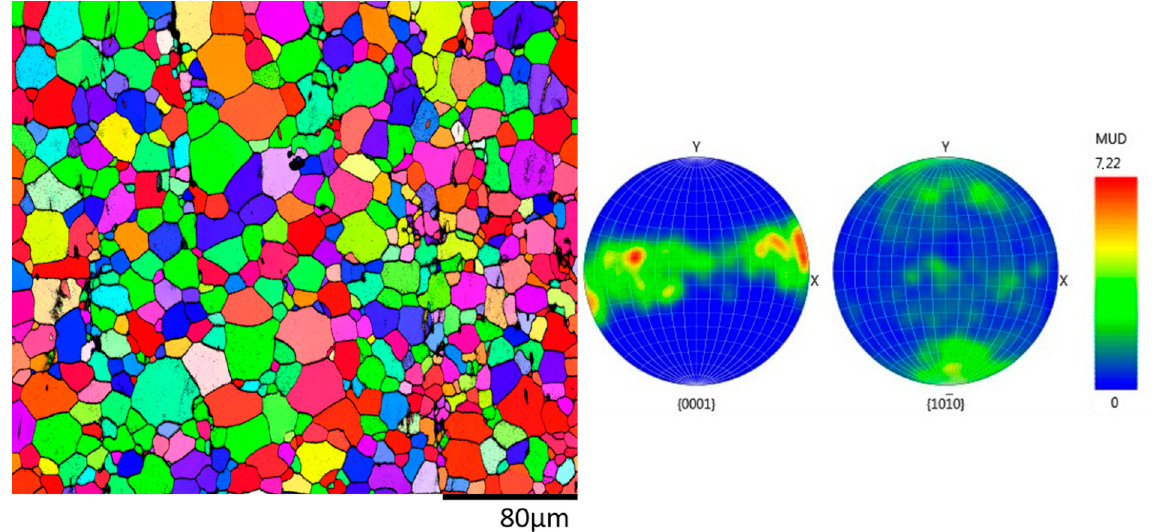
Figure 5. Inverse pole figures and corresponding pole figures for Mg-2Zn-0.6Ca-1Er (where x = Transverse Direction and y = Extrusion Direction).